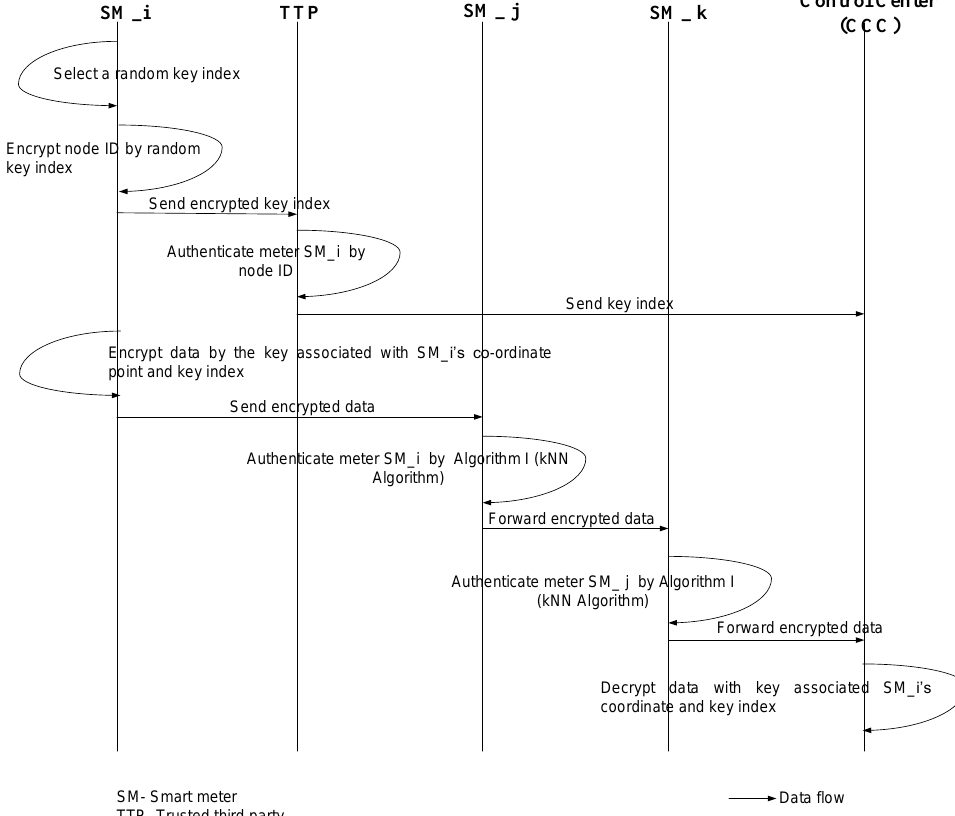
Figure 3. Encryption and data transmission process among various components of AMI. CCC: command and control